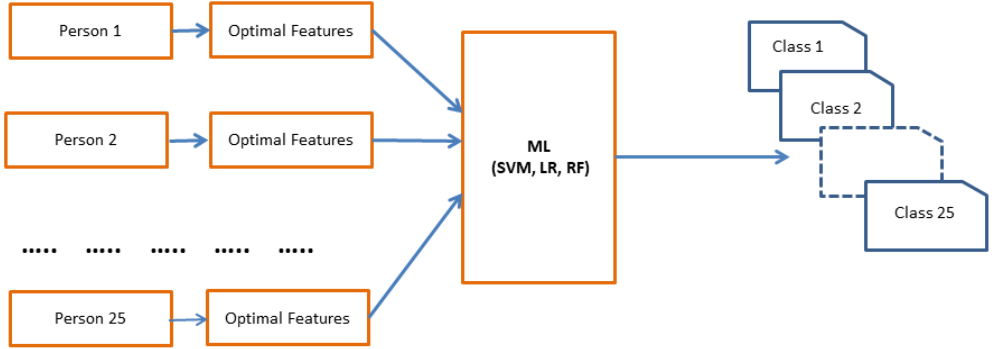
Figure 8. Block Diagram of User Authentication Process.